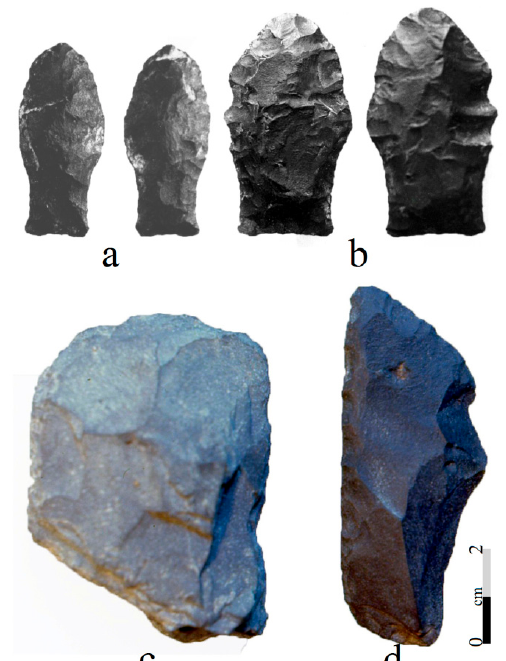
Figure 14. Bifacial and unifacial implements exhumed in the Paleo-American level of CM ( a , b ) “Fishtail” projectile points, ( c , d ) unifacial tools.